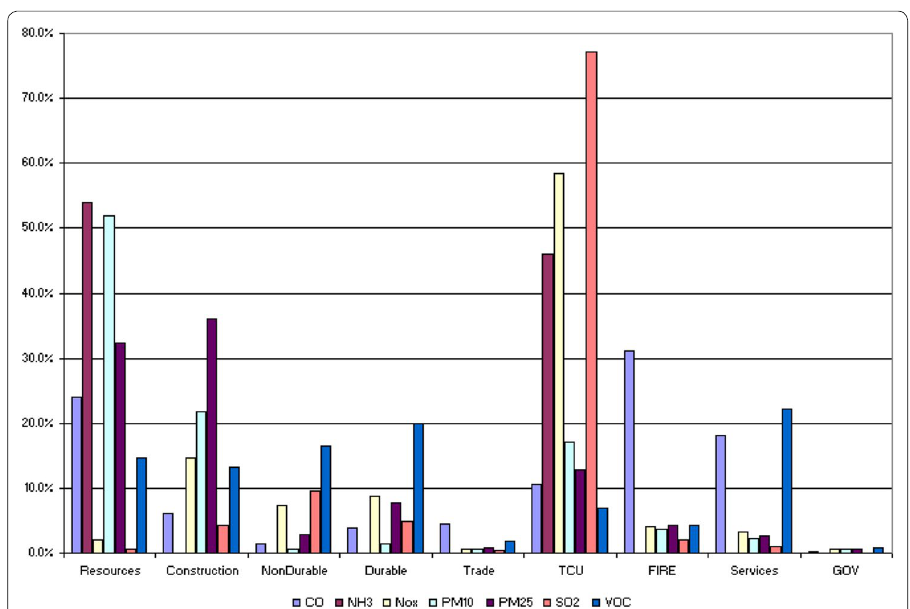
Fig. 11 Percentage distribution of seven air pollutant emissions in 2050 under the time-varying